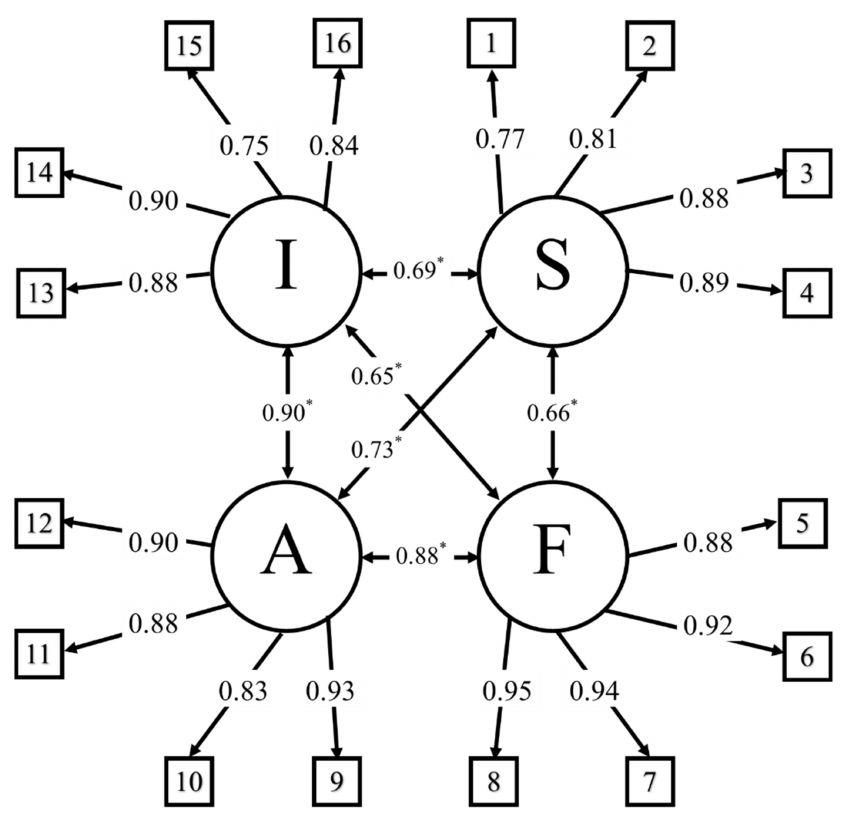
Figure 2. Confirmatory factor analysis for RED-TIC scale. * Double-headed arrows represent covariances in confirmatory factor analysis [41]. Factors are represented in circles, and variables 1 to 16 in boxes.